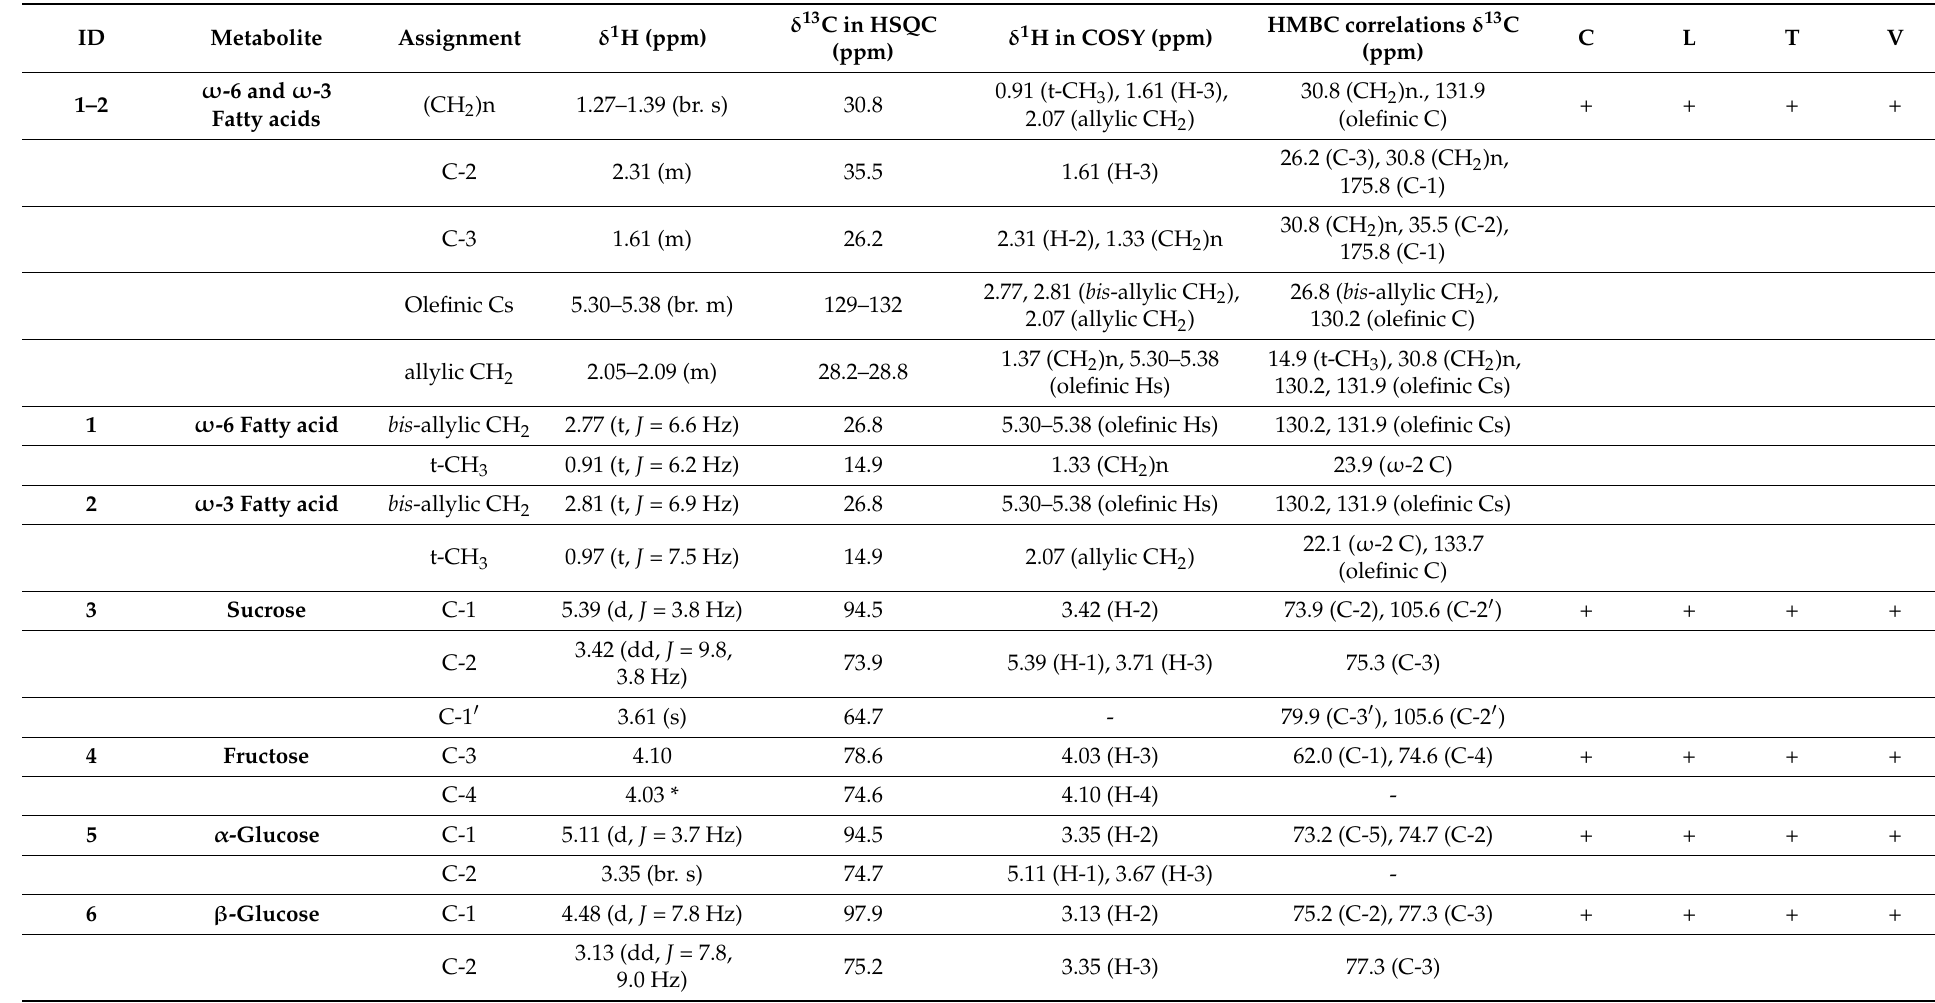
Table 1. Resonance assignments with chemical shifts of constituents identified in 600 MHz 1 H-NMR, HSQC, COSY, and HMBC spectra of legume sprout methanol